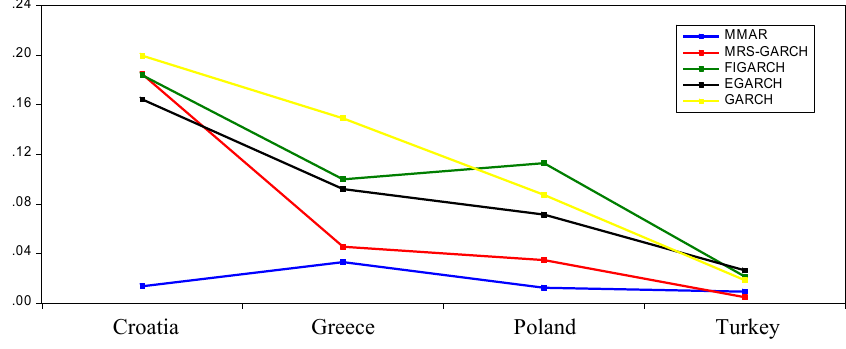
Figure 4. Path of the standard deviation of scaling function values.